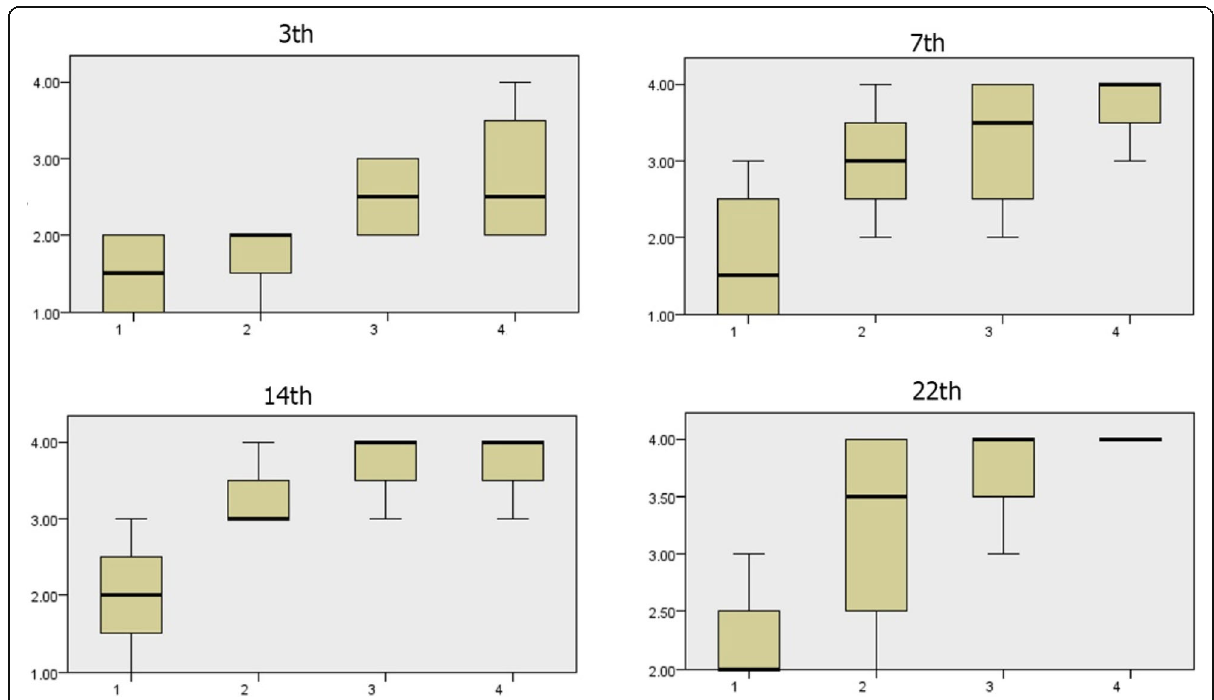
Fig. 1 Wound epidermis scores during the 3rd, 7th, 14th, and 22nd days. There is a significant difference in the amount of formation of wound epidermis during the 3rd, 7th, 14th, and 22nd days in groups, and more epidermis formation causes more improvement. The amount of wound epidermis formation in the treated groups was more than the control group. (1) Control group, (2) Satureja khuzistanica -treated group, (3) alginate hydrogel dressing-treated group, and (4) alginate hydrogel/ Satureja khuzistanica dressing-treated